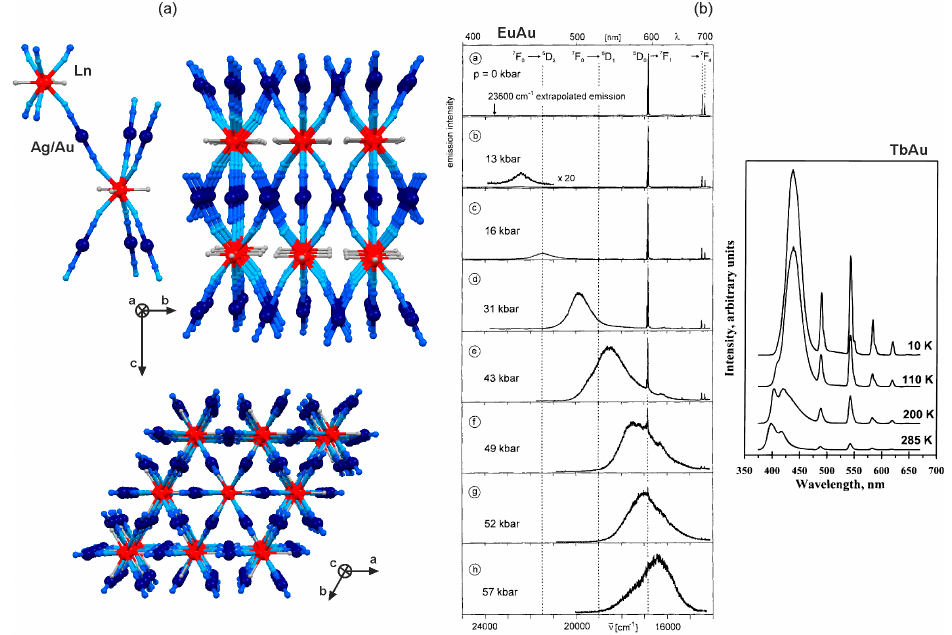
Figure 1. Crystal structure and optical properties of three-dimensional [Ln III (H 2 O) 3 ][M I (CN) 2 ] 3 (Ln = La, Ce, Pr, Nd, Sm, Eu, Gd, Tb, Dy; M = Ag, Au) cyanido-bridged coordination polymers: ( a ) the views of the representative fragment of the structure together with the views of the whole network along a and c crystallographic directions, ( b ) the low-temperature ( T = 20 K, λ exc = 364 nm) pressure-dependent emission spectra of EuAu network, and the temperature-dependent emission spectra of TbAu compound ( λ exc = 350 nm). Colours for the structural diagrams: Ln, red; Ag/Au, dark blue; CN − , blue; H 2 O, grey [57,58,60]. Reprinted with permission from Inorg. Chem. 1998 , 37